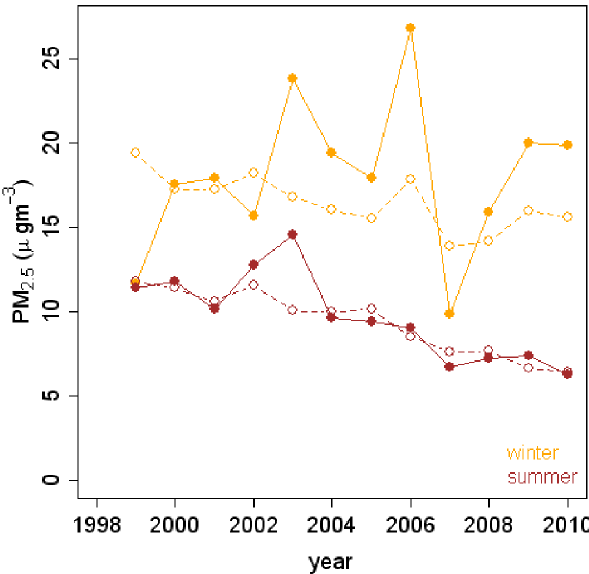
Fig. 7. Frequency of occurrence of high-PM GWL for each year at Illmitz. Fig. 8. Seasonal median PM